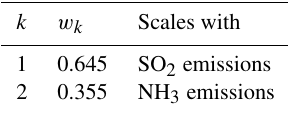
Table 5. Weights of precursor emission